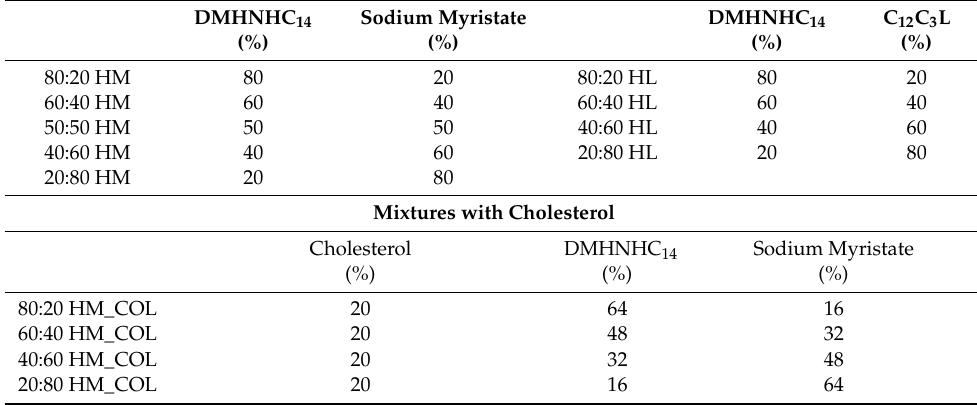
Figure 1. Chemical structure of the cationic (DMHNHC 14 ) and anionic (C 12 C 3 L, sodium myristate) surfactants used to prepare the catanionic mixtures. Table 1. Abbreviations and composition (%, molar) of the prepared catanionic mixtures.